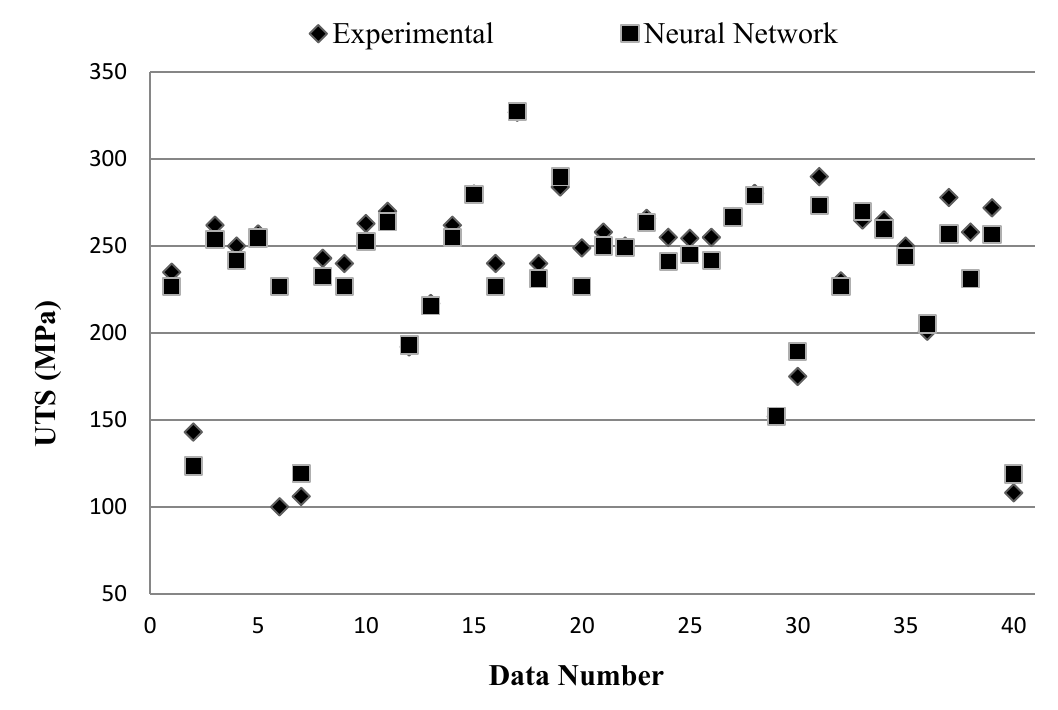
Figure 1. Correlation of NN and experimental results for training